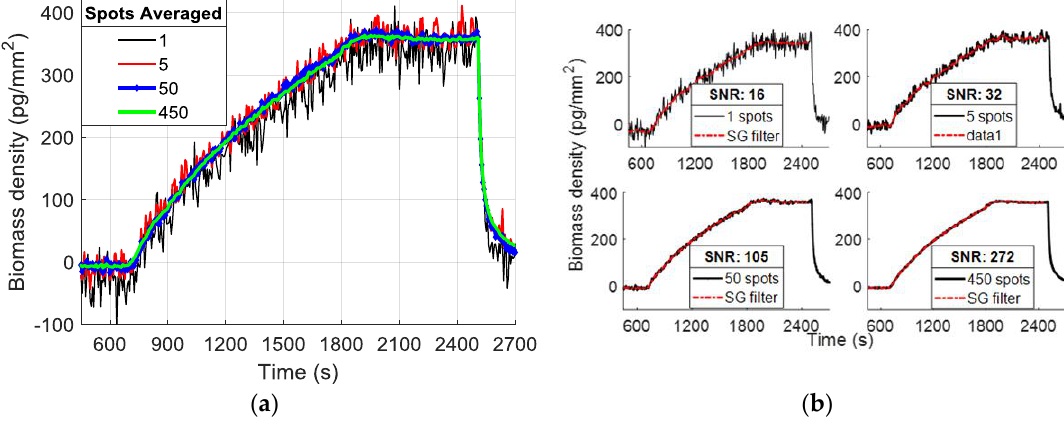
Figure 4. ( a ) Example binding curves from MCP-2 functionalized chip with single drop 1 mg/mL α-lactalbumin spots showing the effect of spatial averaging. ( b ) Binding curves with Savitzky–Golay filtering and their calculated SNR level.